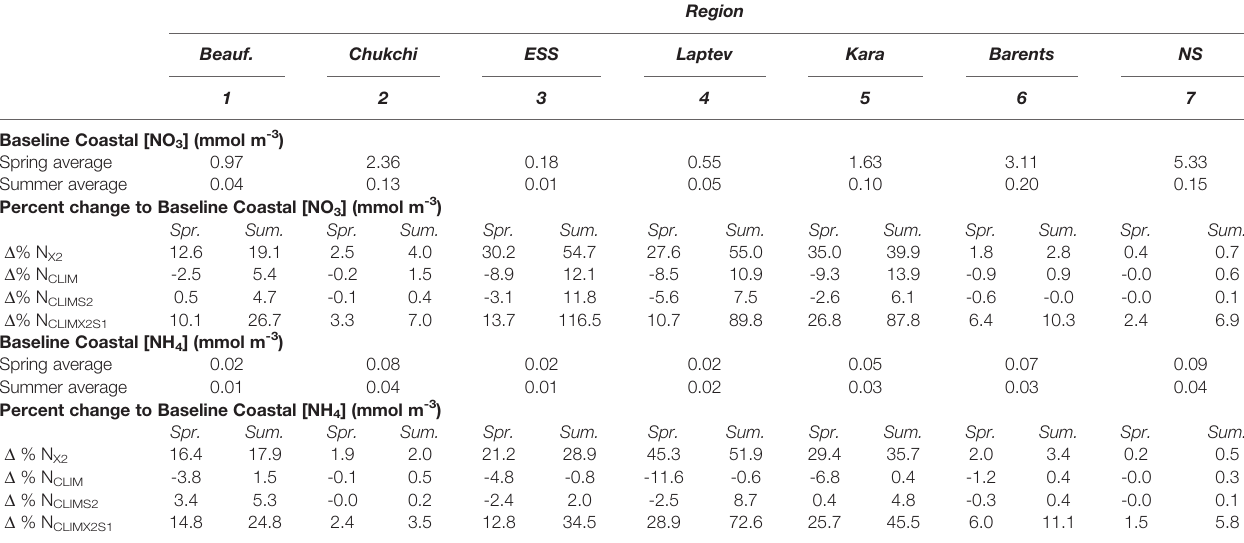
TABLE 1 | Summary of mixed layer nitrate and ammonium concentration in the baseline model ( BASE ) and the change seen in the four river nutrient model scenarios ( EXP ) during Spring (March-May) and Summer (June-August). Region Beauf. Chukchi ESS Laptev Kara Barents NS